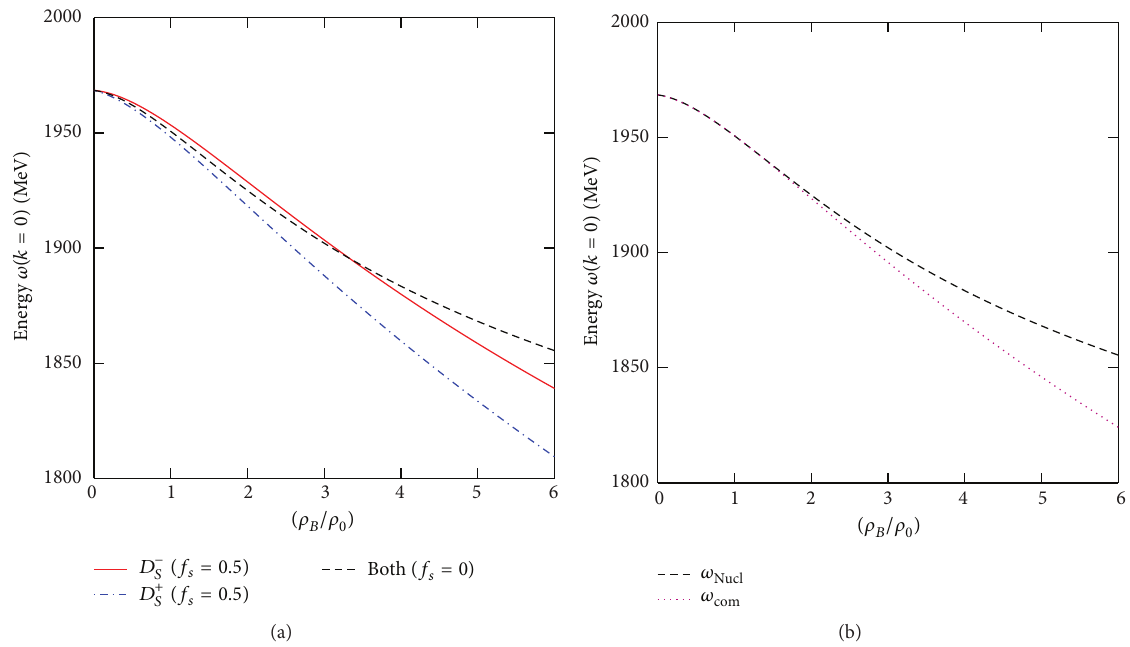
Figure 5: (a) A comparison of medium mass of 𝐷 𝑆 mesons, in nuclear and hyperonic matter, maintaining the same values of parameters as before. (b) Comparison of the nuclear matter solution, 𝜔